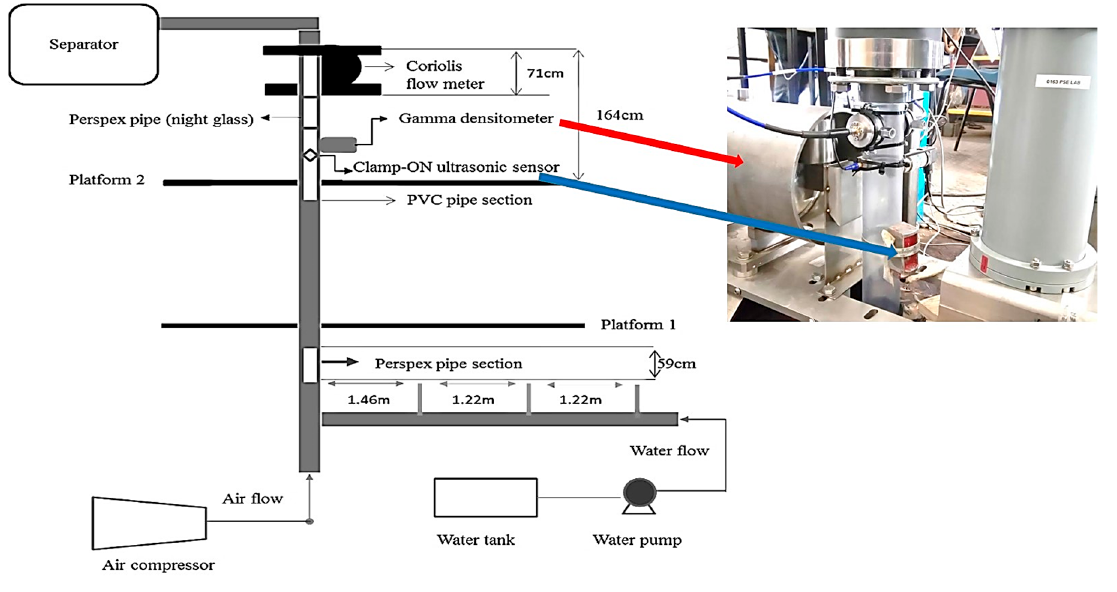
Figure 3. Experimental setup [25].